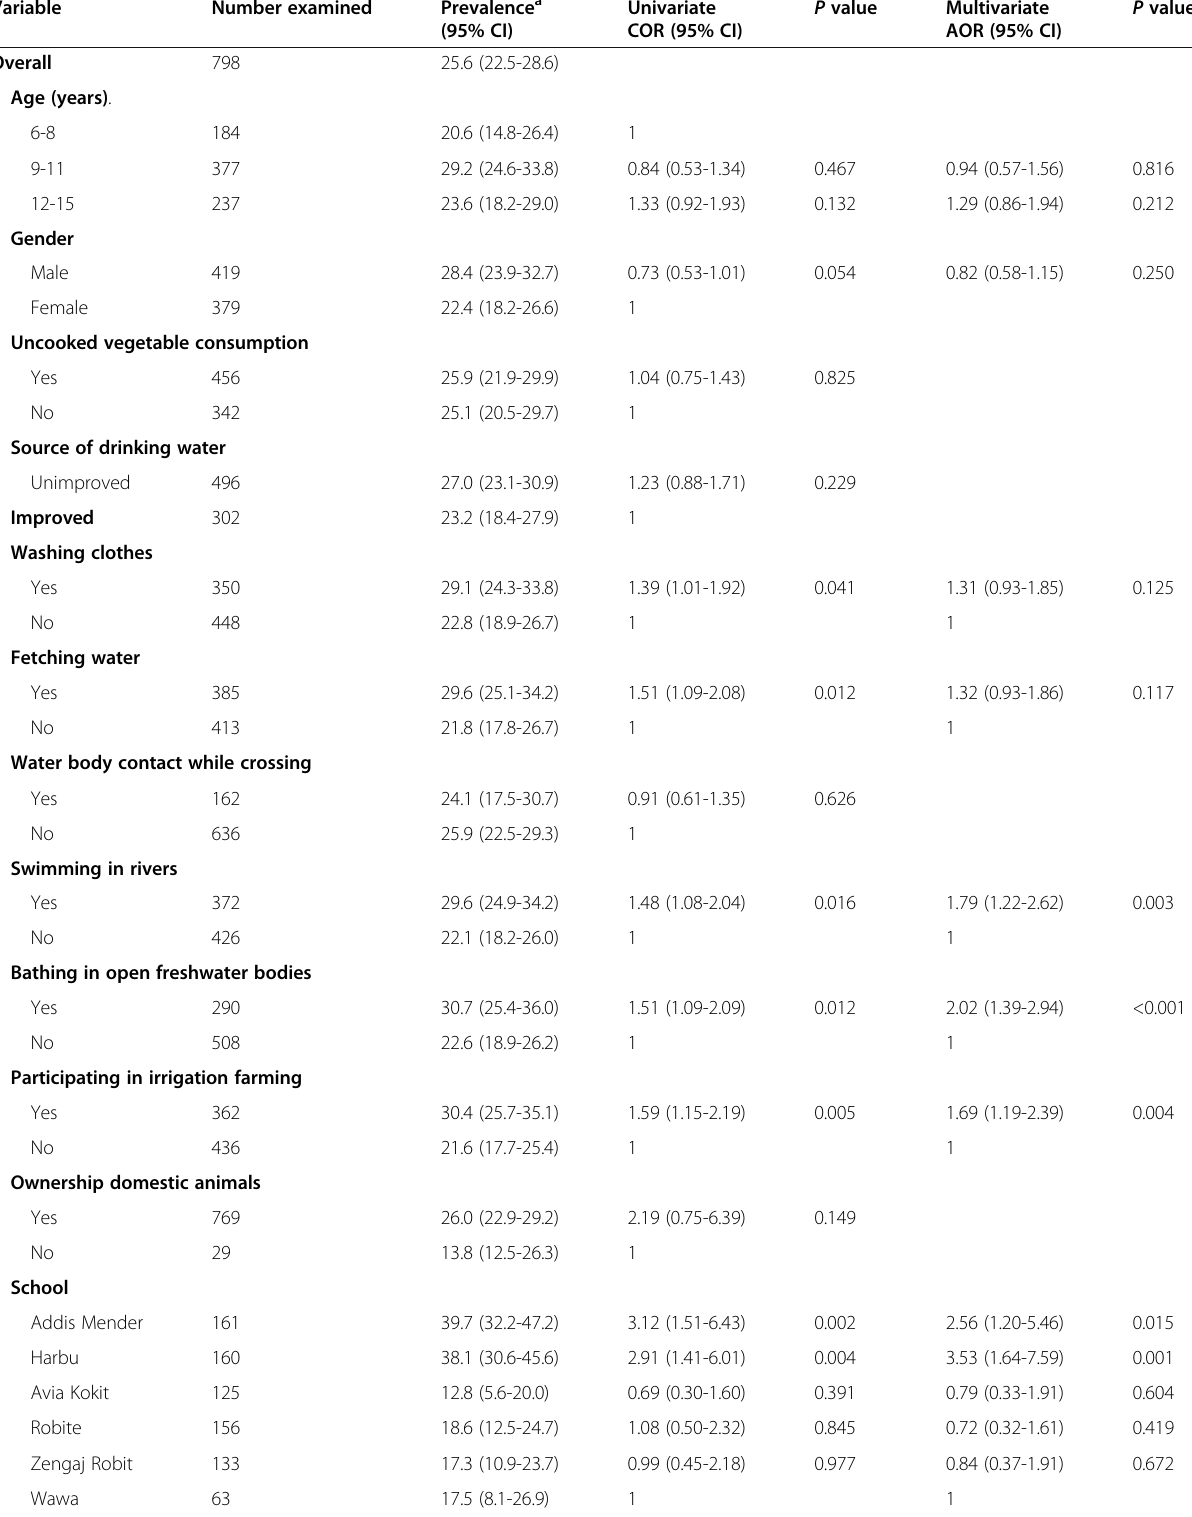
Table 1 Prevalence of S.mansoni infection among the school children in Amhara Regional State, Ethiopia